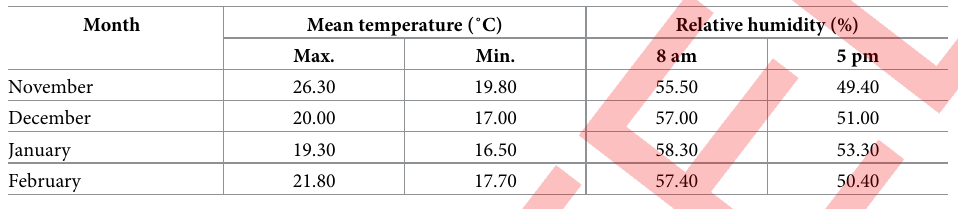
Table 1. Mean maximum (Max.) and minimum (Min.) temperature, and relative humidity during the crop season. Month Mean temperature (˚C)